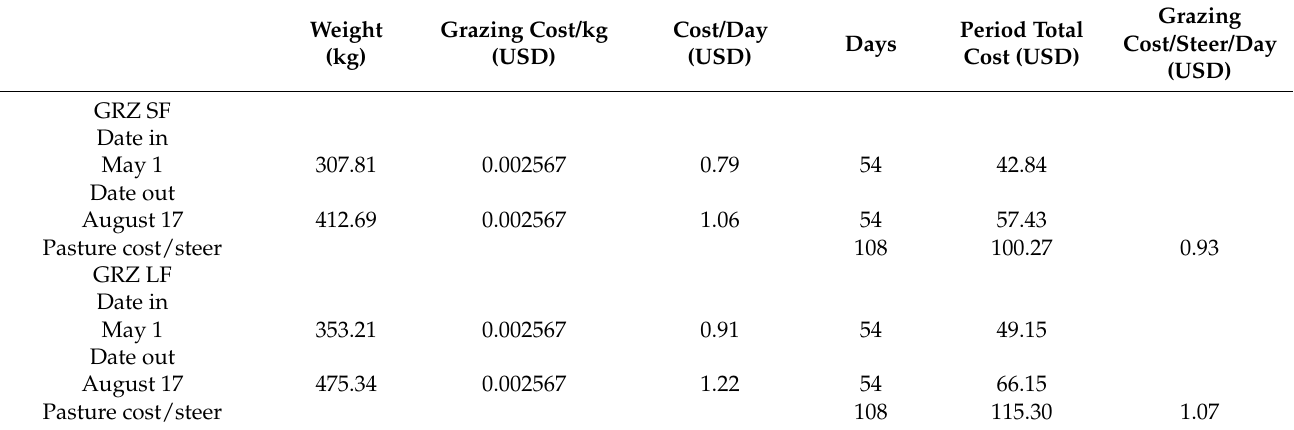
Table 3. Beef steer native range pasture custom grazing rate calculation 1 .